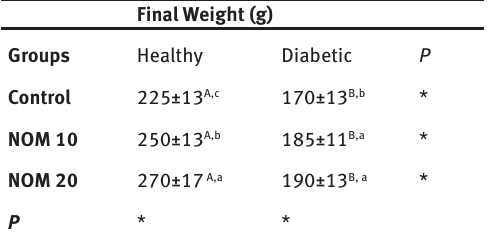
Table 6: Effects of Nannochloropsis oculata microalgae (NOM) at rates of 10 and 20mg.kg -1 of body weight on final body weight (g) in healthy and diabetic